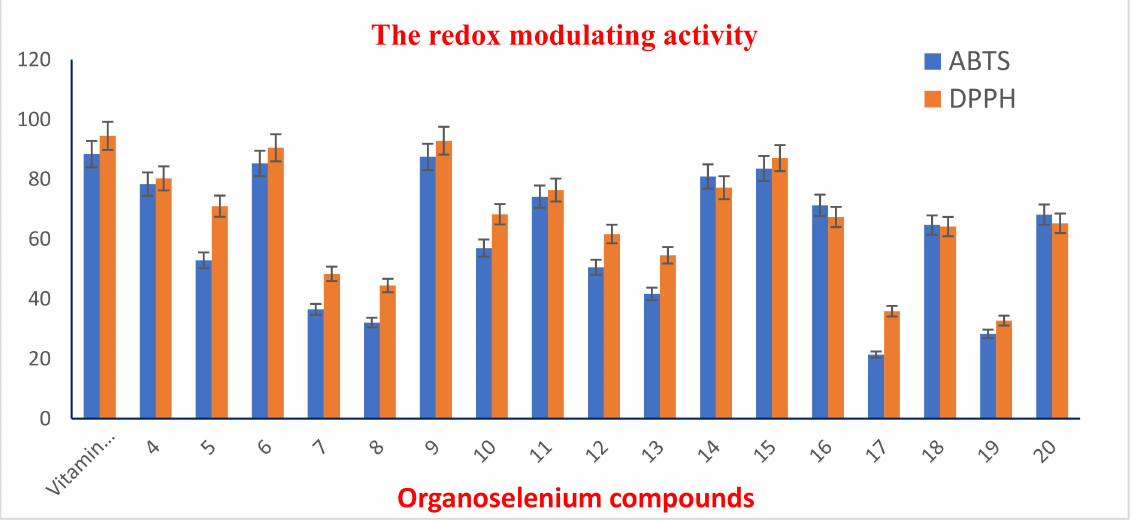
Figure 2. Evaluation of the antioxidant properties of the OSe compounds employing the ABTS and DPPH assays. All measurements are mean ± SD. In the DPPH assay: absorbance was read after 0.5 h of mixing 400 mL of DPPH with 200 mL of OSe compounds (1 mM, MeOH) at 517 nm. In the ABTS assay: 50 mL of each OSe compound (1 mM, phosphate-buffered methanol) was mixed with the ABTS solution (60 mM), and absorbance was monitored at 734